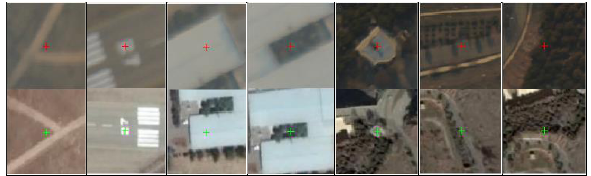
Figure 7. Some examples of matched pairs; up: image frame, and bottom: reference image